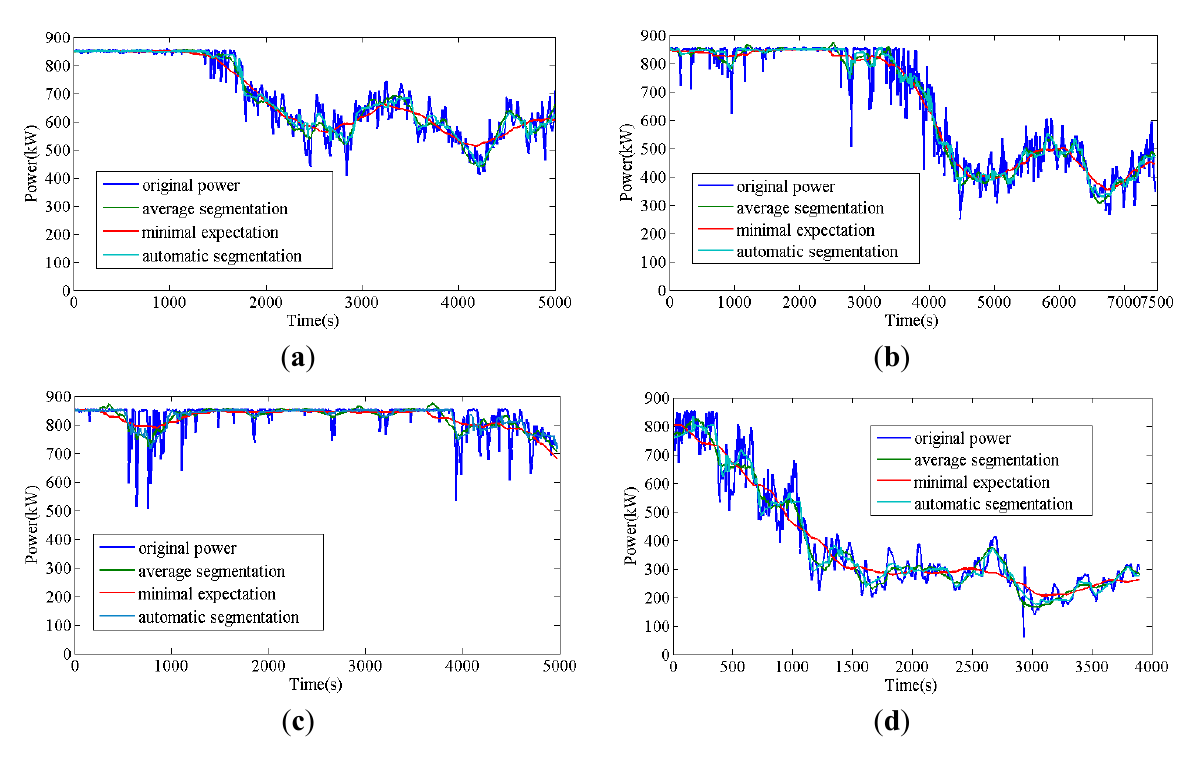
Figure 7. Regulation effect